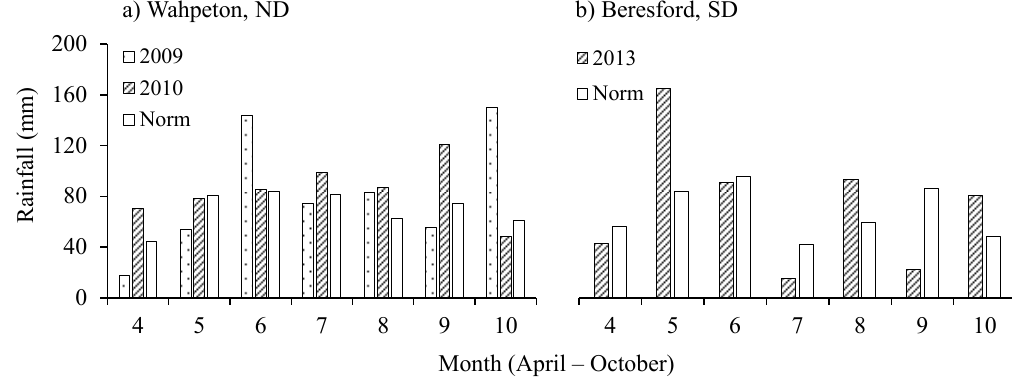
Figure 2. Monthly rainfall observed at the ( a ) Wahpeton (North Dakota) and ( b ) Beresford (South Dakota) weather station during the study years, and the normal rainfall (1980–2010).